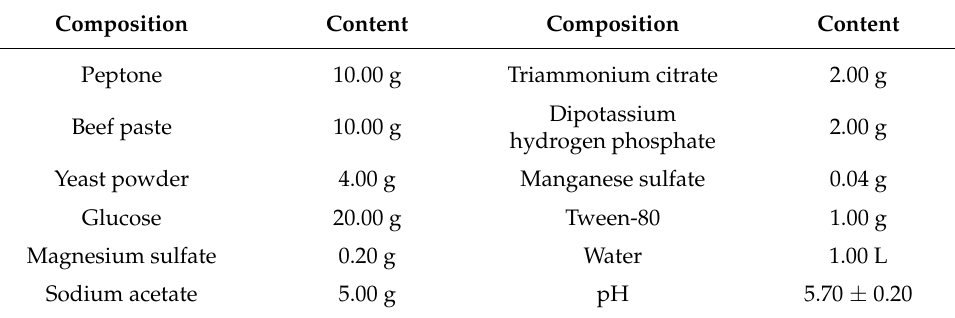
Table 1. The de Mann Rogosa Sharpe (MRS) medium